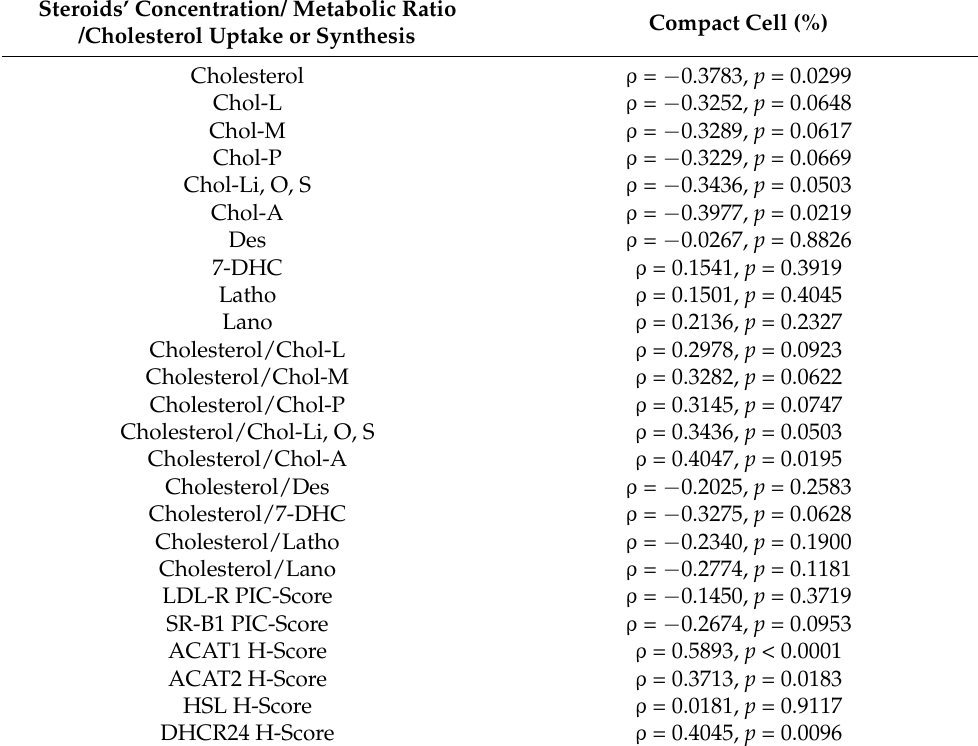
Table 2. Correlations between the percentage of compact cells and the cholesterol uptake/synthesis. The correlation between the percentage of compact cells and concentrations of individual cholesterol and its precursors, their metabolic ratios and immunoreactivity of receptors and enzymes were examined. Free cholesterol and cholesterol ester (Chol-L, Chol-M, Chol-P, Chol-A, Chol-Li, O, S) concentrations were significantly or tended to be inversely correlated with the percentage of the compact cells. The metabolic ratios corresponding to the activity of cholesterol ester metabolism (cholesterol/Chol-L, cholesterol/Chol-M, cholesterol/Chol-P, cholesterol/Chol-P, cholesterol/Chol- Li, O, S) were significantly or tended to be positively correlated with the percentage of compact cells, and cholesterol/7-DHC tended to be inversely correlated. ACAT1, ACAT2 and DHCR24 were positively correlated with the percentage of compact tumor cells, but SR-B1 tended to be inversely